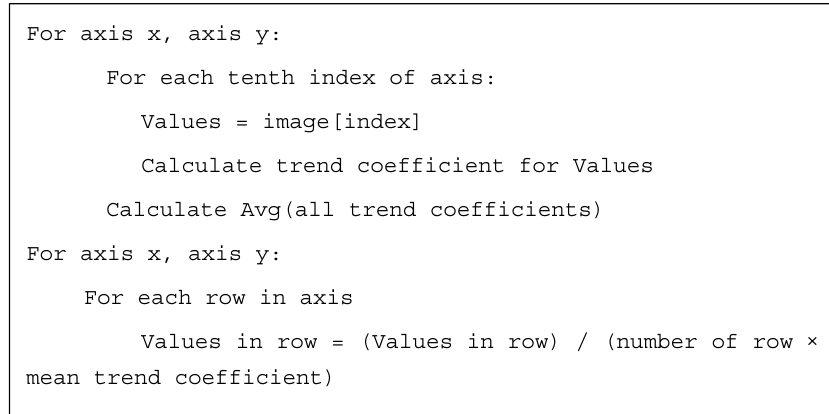
Figure 2. The unwedging algorithm for 2D (x, y) image. Digitally unwedged images are smoothed with Gaussian filter with a small standard deviation for Gaussian kernel (default value for 1024 × 1024 image is 3) and normalized to the range (0,1). Gaussian filtering was performed with the gaussian method from scikit-im- age library [51]. Next, the correlation matrix between images is computed. First, all data is converted to the form of DataFrame from pandas library [52]. Then, the corr method from